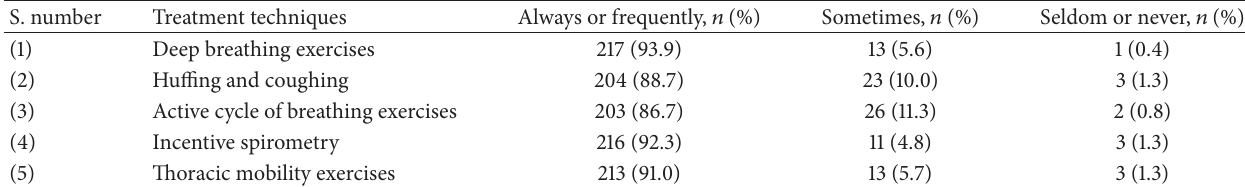
Table 3: Preoperative physiotherapy interventions for thoracic surgery patients.